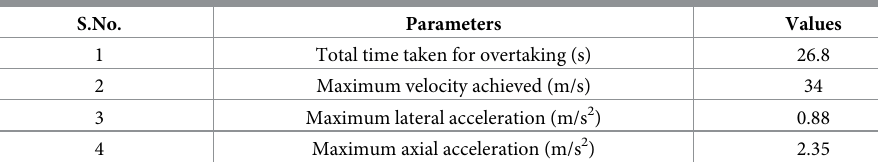
Table 2. Summarized results for scenario 2.